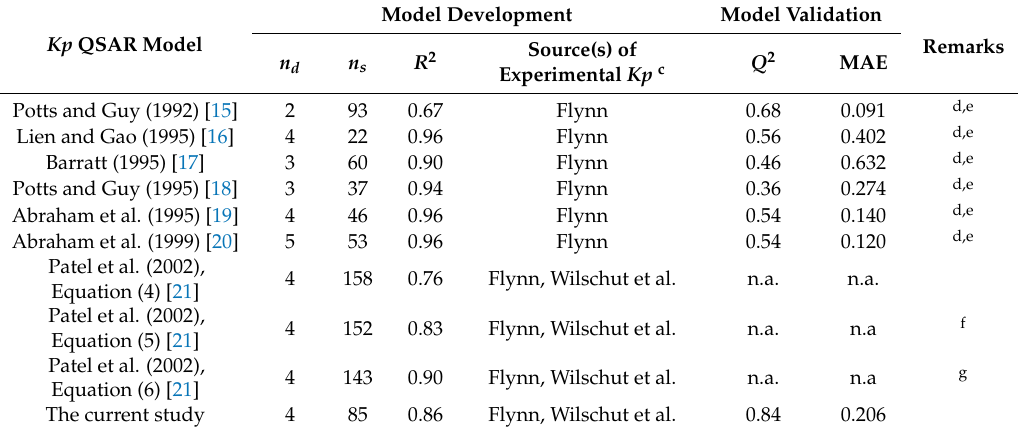
Table 5. Performance of skin permeability model from this study and of those reviewed in literature a,b